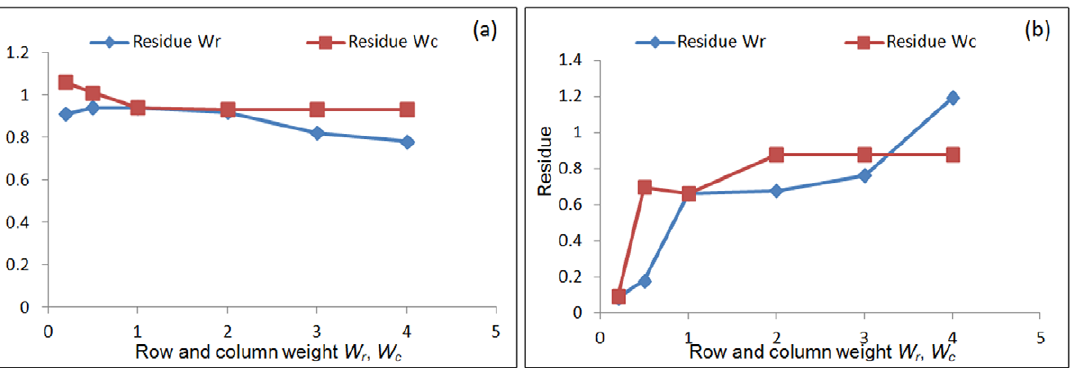
doi:10.1371/journal.pone.0035700.g005